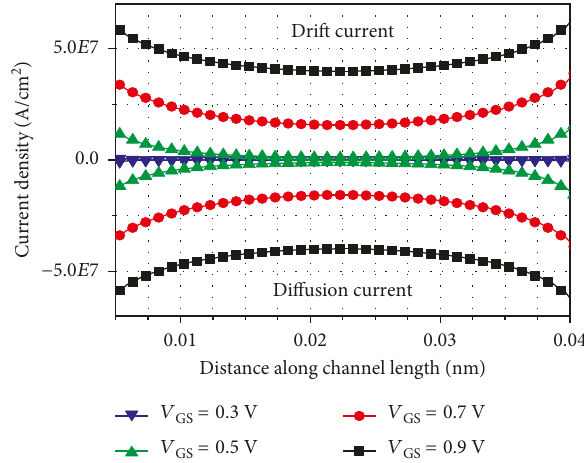
Figure 2: Drift-diffusion current density along the channel length for different gate voltages with V DS